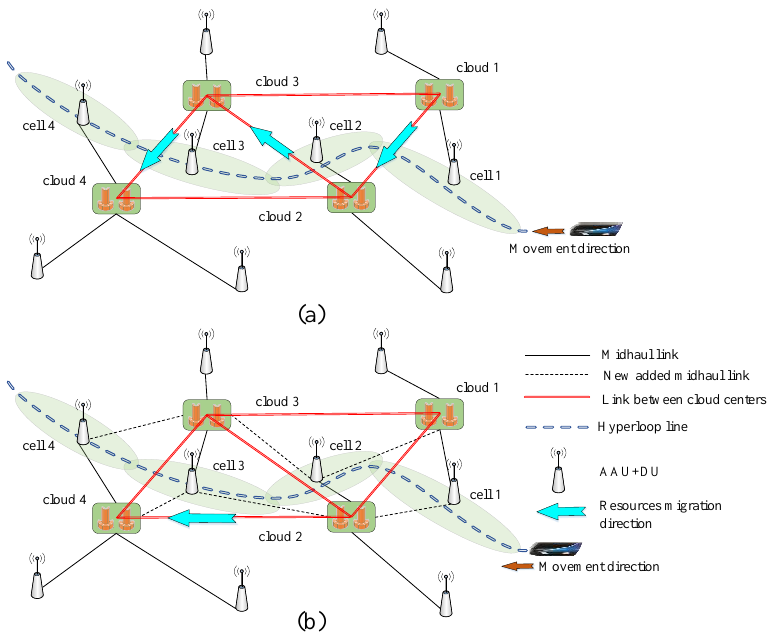
Figure 6. The diagram of the network architecture: ( a ) one-to-many; ( b ) many-to-many.